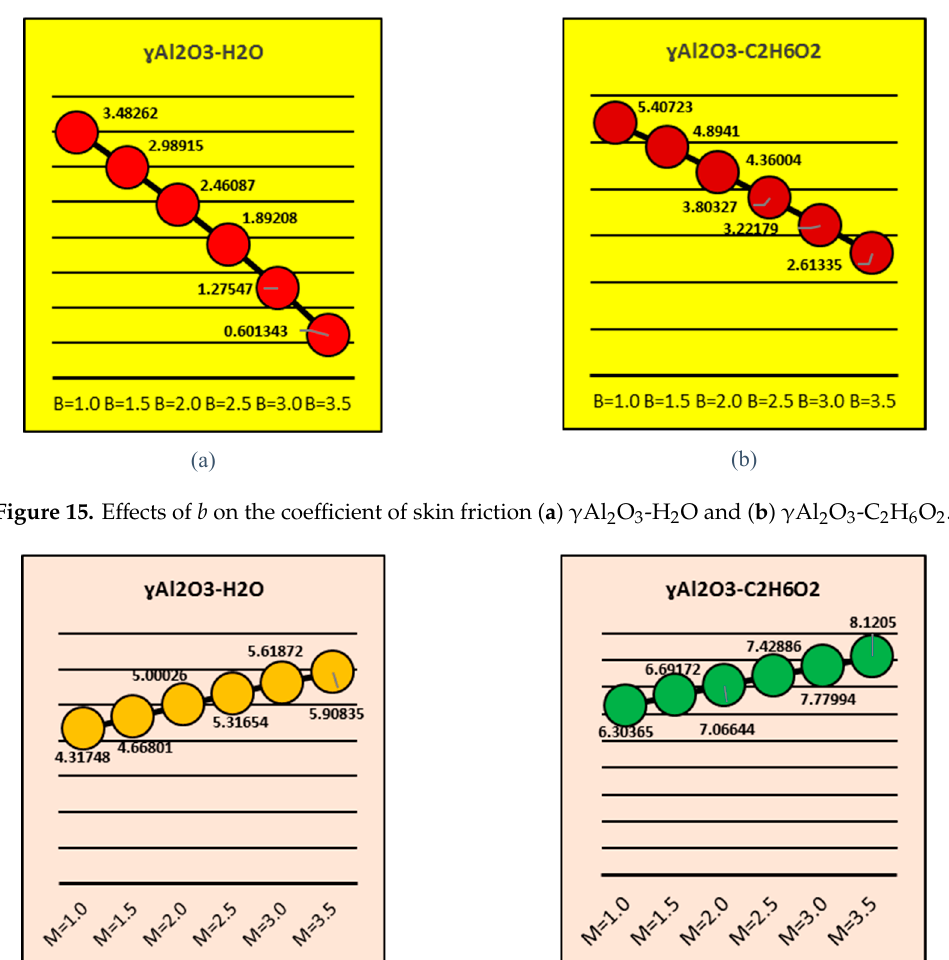
Table 1. Reliability of the presented analysis (numerical values for skin friction coefficient) 𝑓 (cid:2869) = −0.5,𝑀 = 0.5,𝑏 = 1.0 𝜙